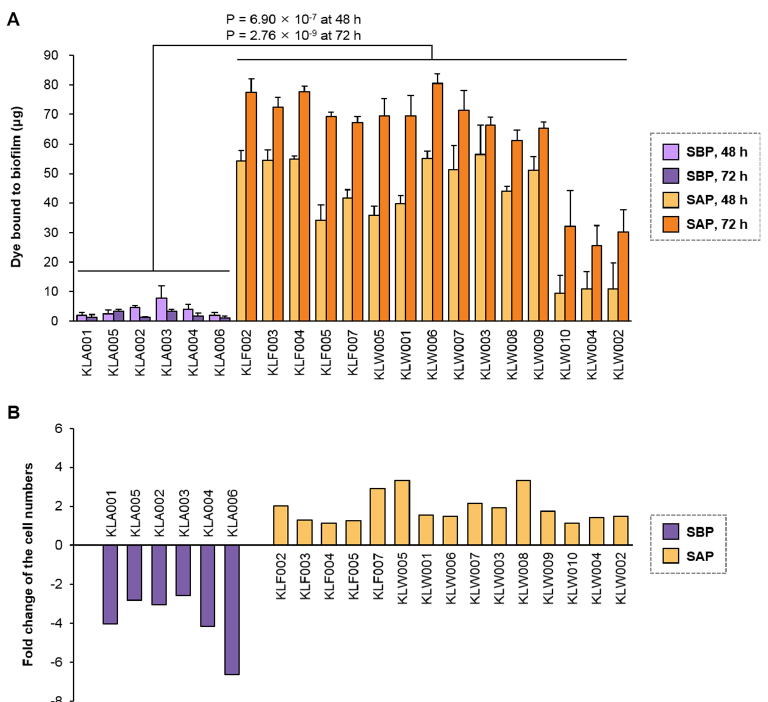
Fig 6. In vitro confirmation of the survival characteristics. (A) Detection of biofilm formation at 48 h and 72 h after incubation. (B) Fold changeof the cell numbers of the isolatedstrains in competition with swine intestinalmicrobiota. The difference in the cell numbers between24 h and 48 h after incubation was calculated. The cell number quantification results are shown in S3 Fig.